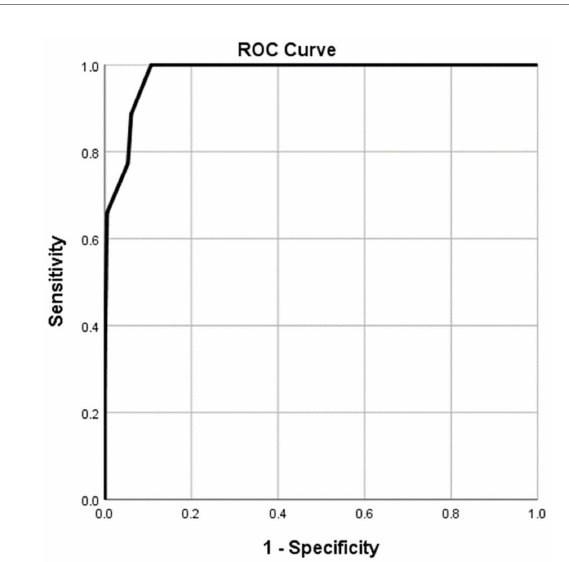
FIGURE 3 Using characteristics of NRS2002 score for discriminating the critical cases from the non-critical patients ( n = 1,228; critical and non- critical groups, n = 44 and 1,184, respectively). ROC analysis showing the performance of NRS2002 score in distinguishing critical cases from non-critical patients. The parametric estimate of the area under the ROC curve and its 95% confidence interval are 0.980 and 0.970 ~ 0.990, respectively. ROC, receiver operating characteristic curve; AUC, area under the curve.